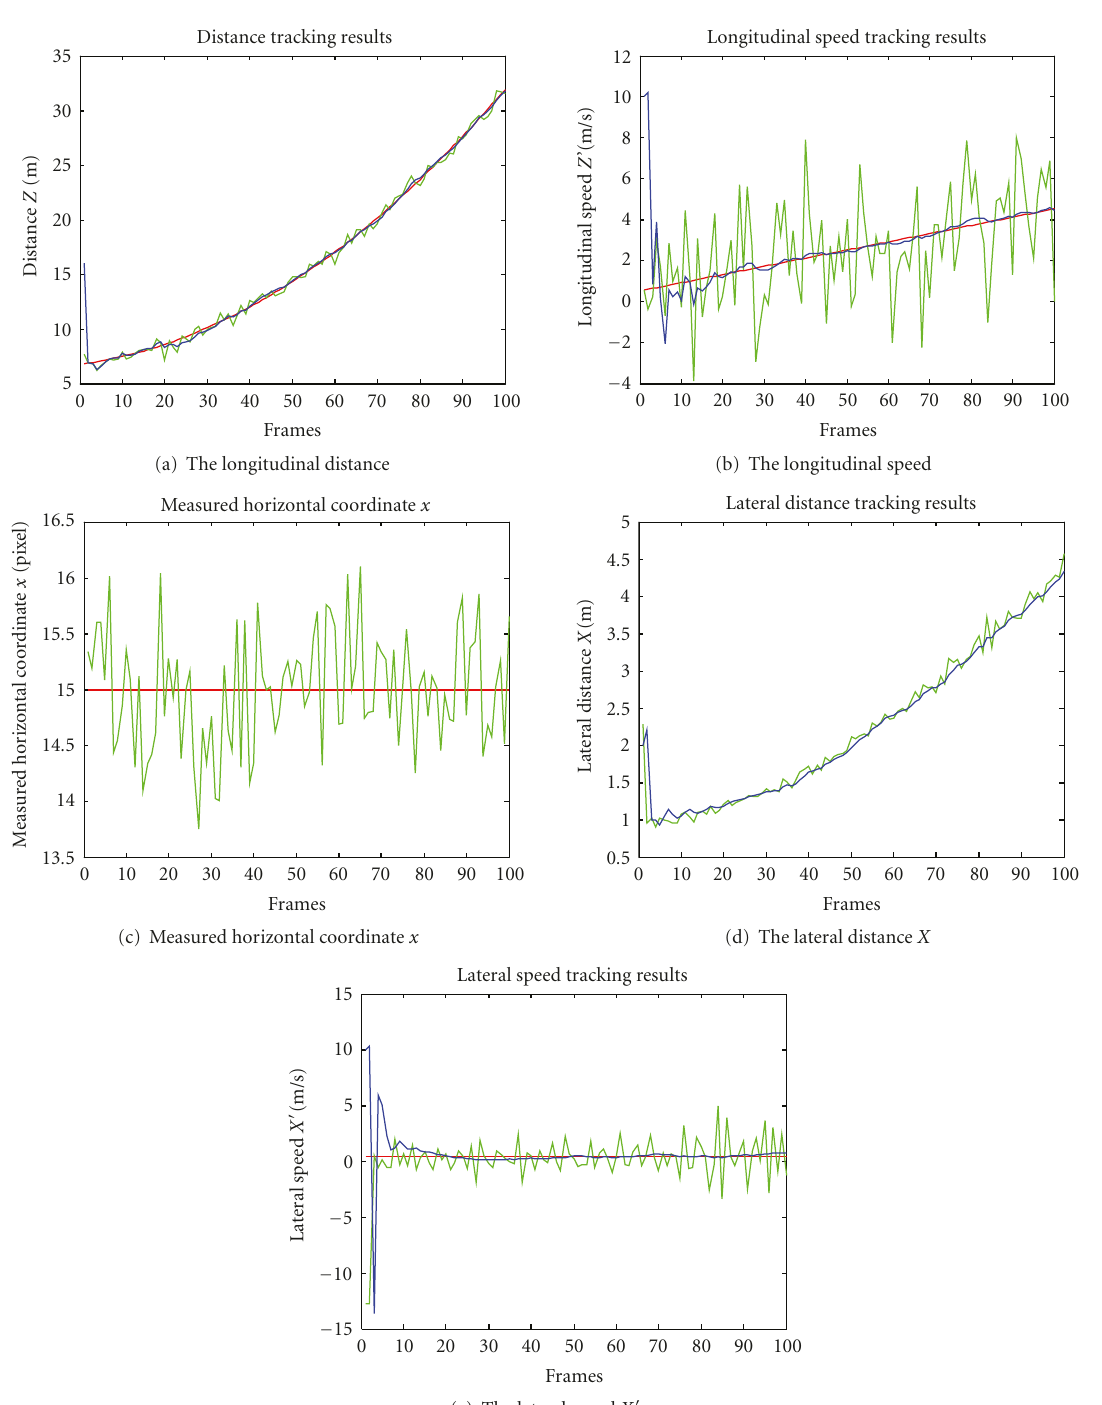
Figure 6: Experiment 2: tracking results by using Kalman filter as a mixer (red: the true state of the system, green: the measurement results, blue: the estimation of the Kalman